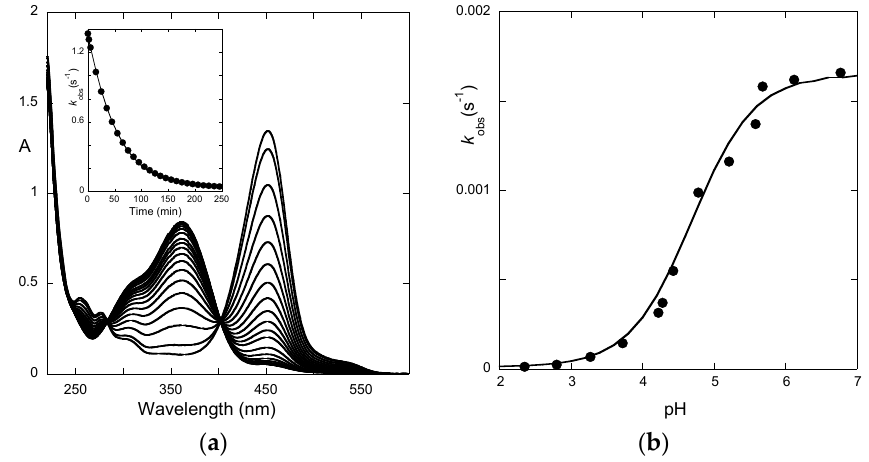
Figure 6. ( a ) spectral variations of P3 (5.4 × 10 − 5 M) after a direct pH jump from pH = 1.0 to pH = 3.3; k obs = 3.1 × 10 − 4 s − 1 ; and ( b ) plot of the apparent rate constant as a function of pH; curve-fitting was achieved with Equation (11): K h K t k i = 3.4 × 10 − 8 M s − 1 ; k − i = 5.6 × 10 − 6 s − 1 ; K ^a set at 10 − 4.7 .